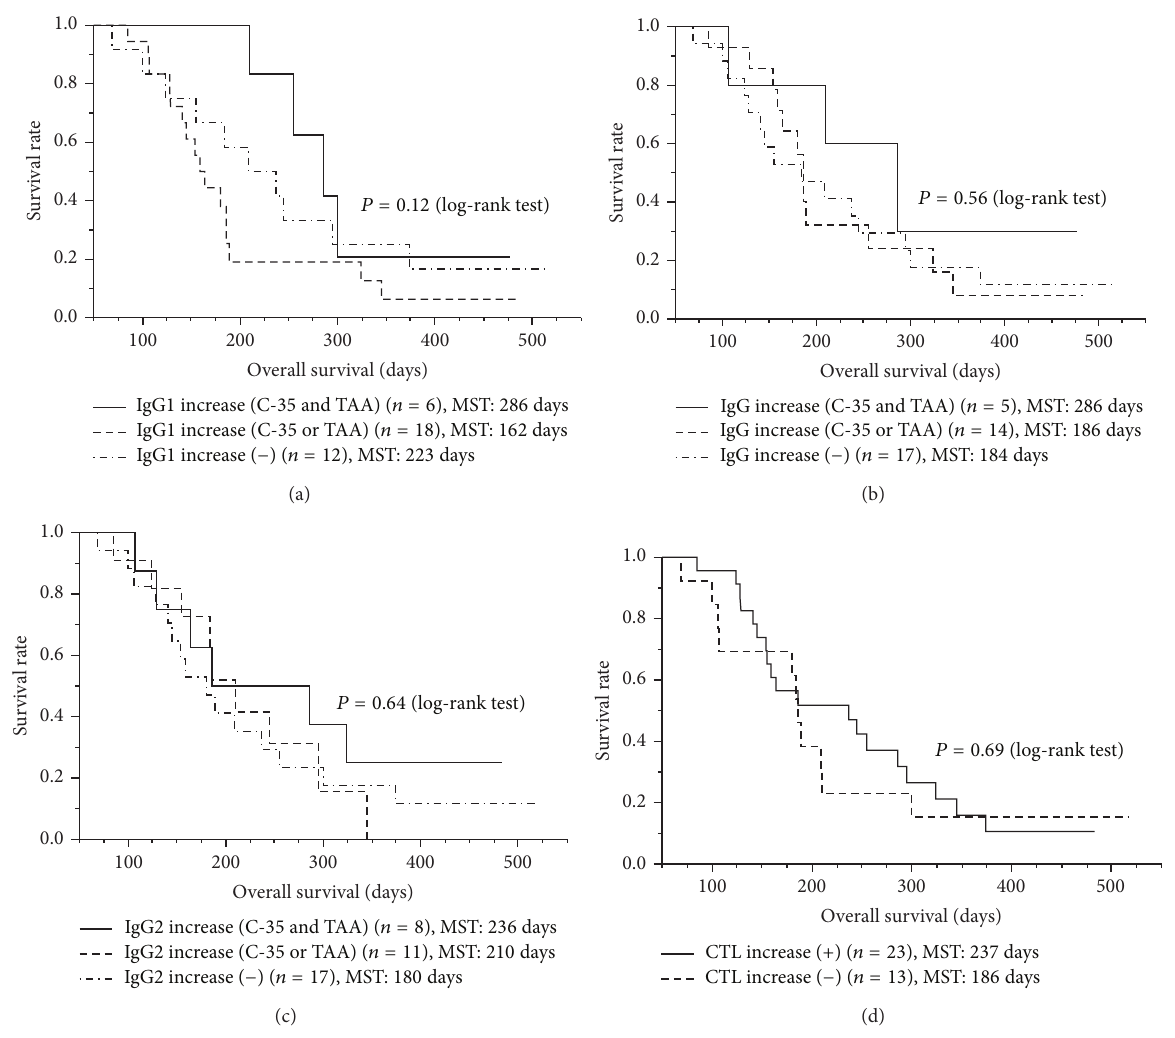
Figure 2: Immune response and overall survival. Association between immune responses and OS was examined with the Kaplan-Meier method, and a comparison of the survival curves was performed with the log-rank test. (a) The peptide-specific IgG1 response was potentially prognostic ( 𝑃 = 0.12 by log-rank test, 𝑃 = 0.06 by Wilcoxon test); all 6 patients showing increased IgG1 responses to both the C-35 peptide and TAA-derived peptides survived more than 210 days, and their MST (286 days) tended to be longer than that of patients showing increased IgG1 responses to either peptide (162 days) or that of patients showing no increase to any peptide (223 days). (b) The peptide-specific IgG response was not prognostic ( 𝑃 = 0.56 ). (c) The peptide-specific IgG2 response was not prognostic ( 𝑃 = 0.64 ). (d) The peptide-specific CTL response was not prognostic ( 𝑃 = 0.69